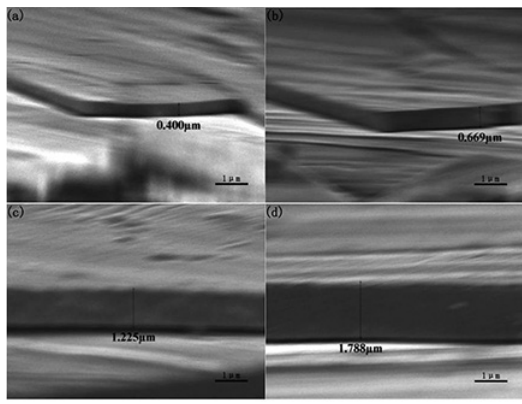
Figure 7: Thickness of the coatings at different time under 100 W plasma power. (a) 10 min, (b) 20 min, (c) 40 min, (d) 60